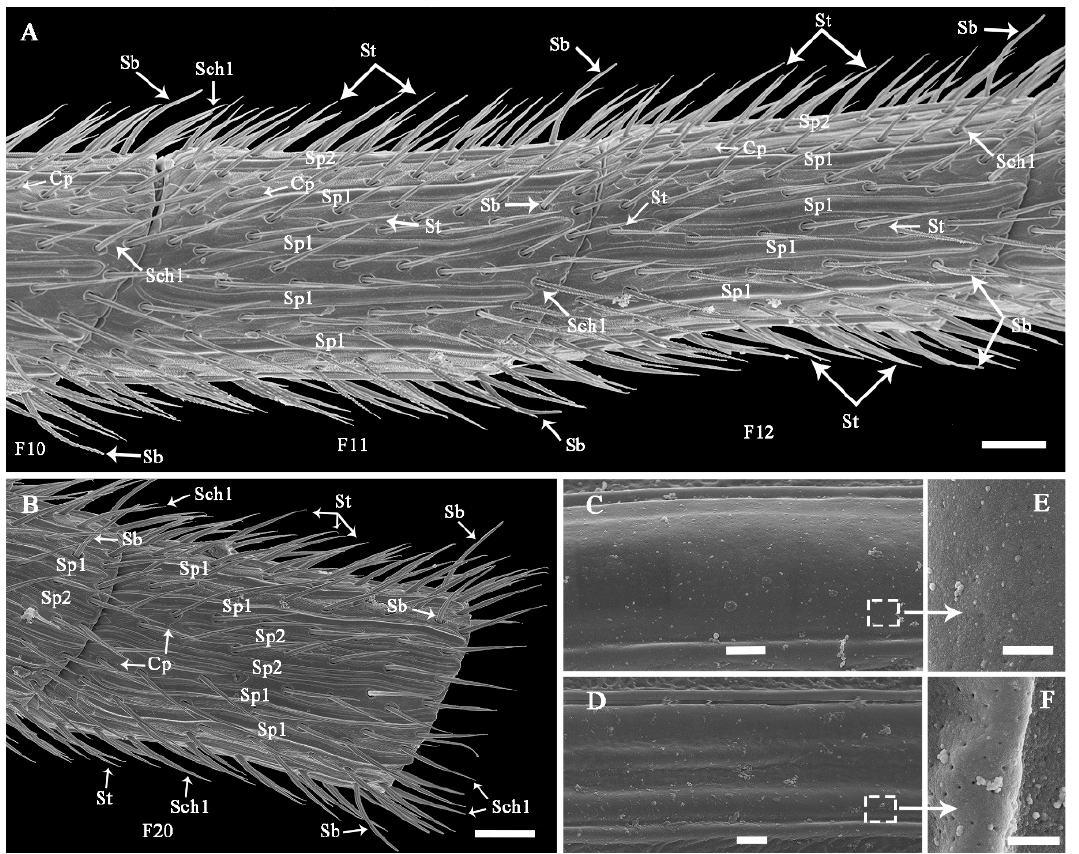
Figure 8. Fine morphology and distribution of antennal sensilla on mid flagellomeres of Coeloides qinlingensis . ( A ) Lateral view of the mid flagellomeres. ( B ) Lateral view of flagellomere 20. ( C ) Smooth surface of sensilla placodea 1. ( D ) Concave surface of sensilla placodea 2. ( E ) Low-density pores on sensilla placodea 1. ( F ) High-density pores on sensilla placodea 2. Cp, cuticular pore. The same acronyms and abbreviations are used in subsequent figures. Scale bar: A and B = 20 μ m; C and D = 1 μ m; E and F = 200 nm.